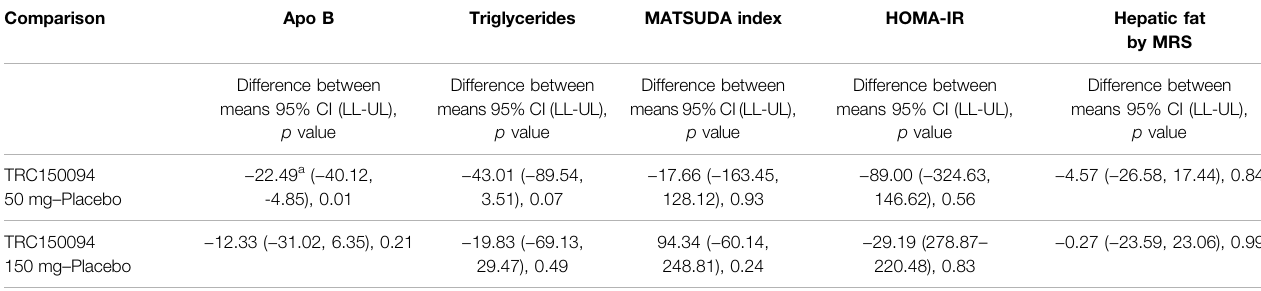
TABLE 6 | Comparison of TRC150094 50 and 150 mg with placebo for percentage change of pharmacodynamic markers using Dunnett ’ s test while adjusting for the change in body weight. Comparison Apo B Triglycerides MATSUDA index HOMA-IR Hepatic fat